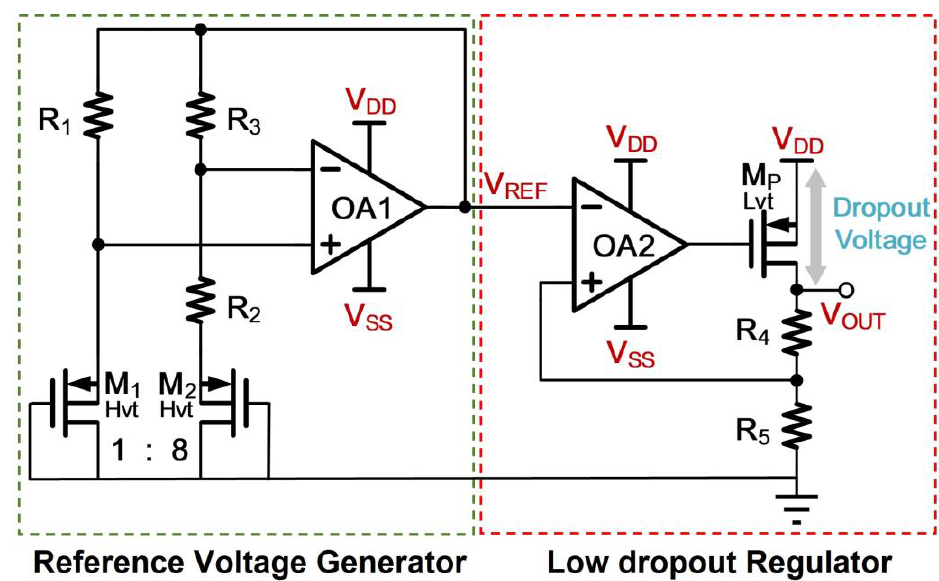
Figure 3. Conventional PSR Enhancer with PSR Design Aware.